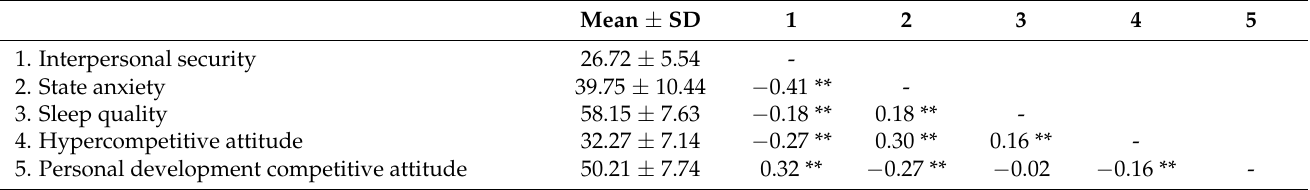
Table 1. Descriptive statistics and bivariate correlation coefficients between measured variables (n = 713).